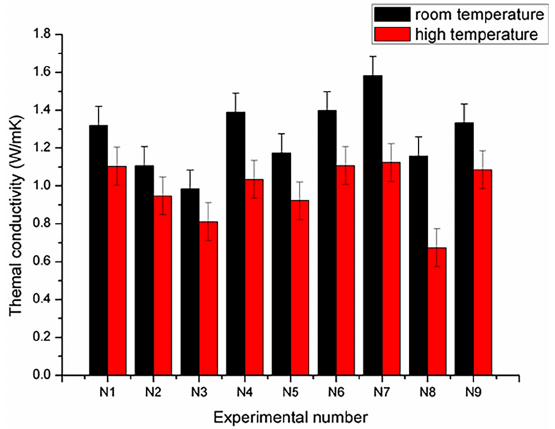
Figure 5. Thermal conductivity of APS coatings at 25 °C and 1200 °C.